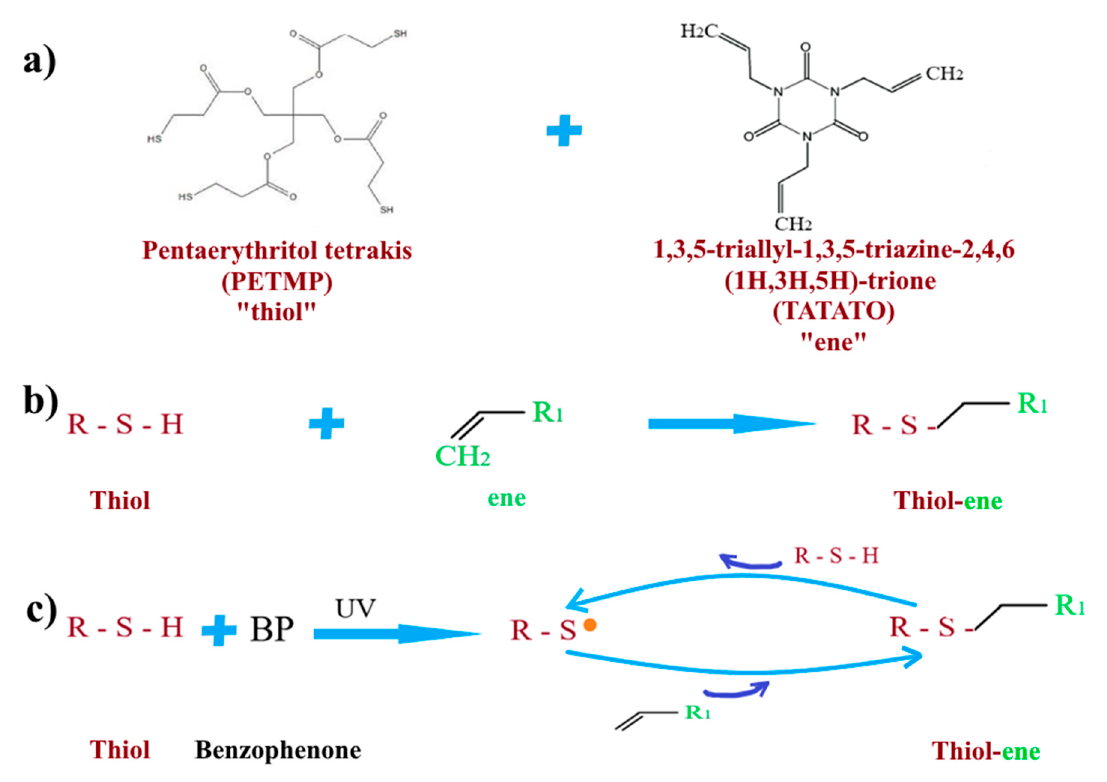
Figure 1. Thiol-ene reaction. ( a ) molecular formulas of PETMP and TATATO; ( b ) and ( c ) mechanism of thiol-ene reaction.